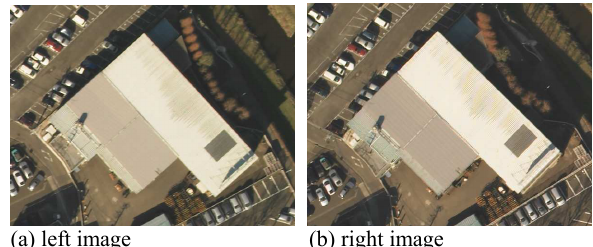
Figure 8. Clipped digital camera images